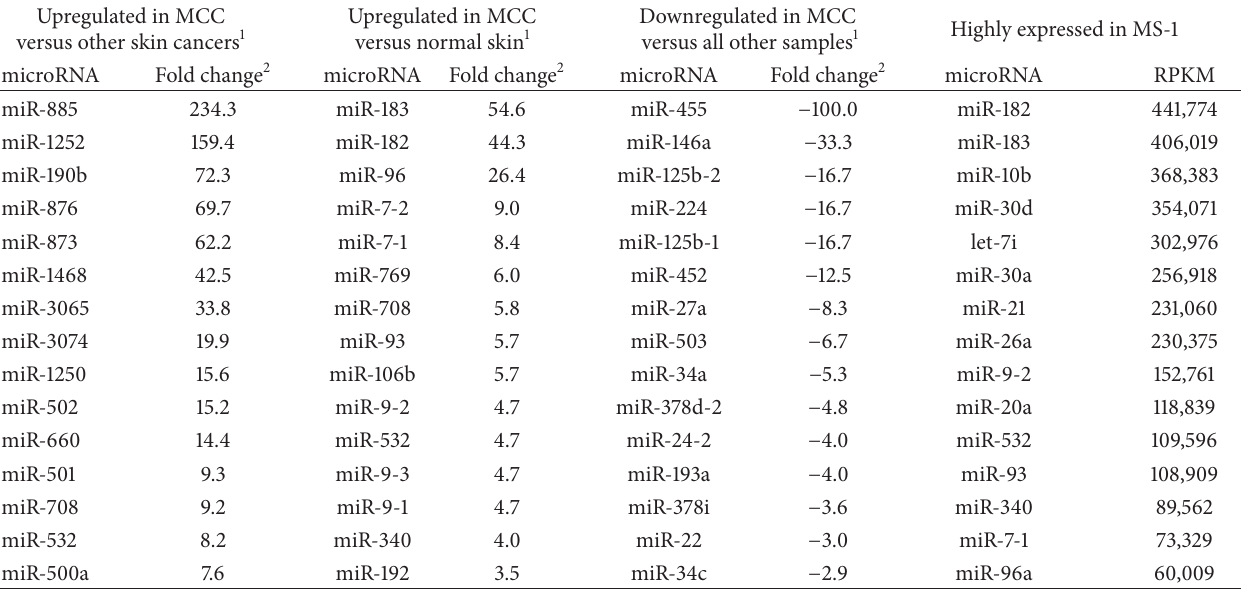
Table 2: MCC-miR candidates identified via NGS. Lists of top fifteen microRNAs upregulated and downregulated in MCC ( 𝑛 = 3 ) versus other tissues (1 melanoma, 1 SCC, 1 BCC, and 1 normal skin sample) and list of fifteen microRNAs expressed in MS-1, based on NGS data. Upregulated in MCC versus other skin cancers